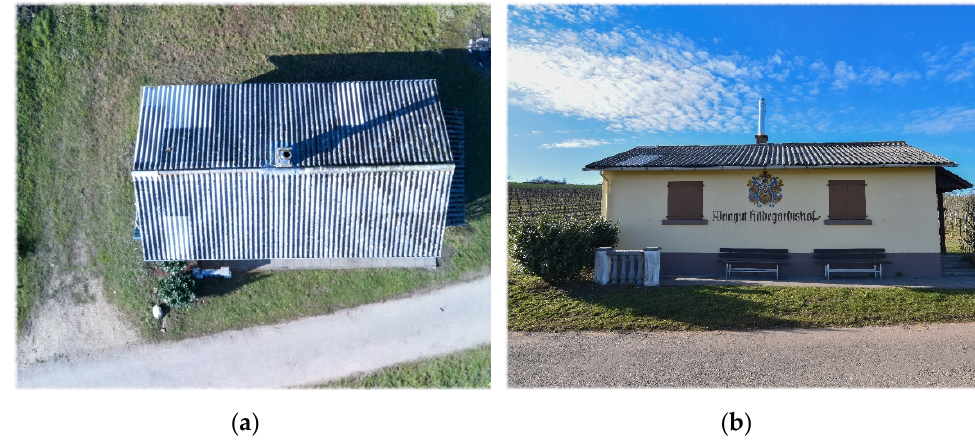
Figure 2. Winery located in the municipality of Bingen am Rhein, Germany, that was used to assess the transformation process. ( a ) Image from a flight over the building and ( b ) a front picture.